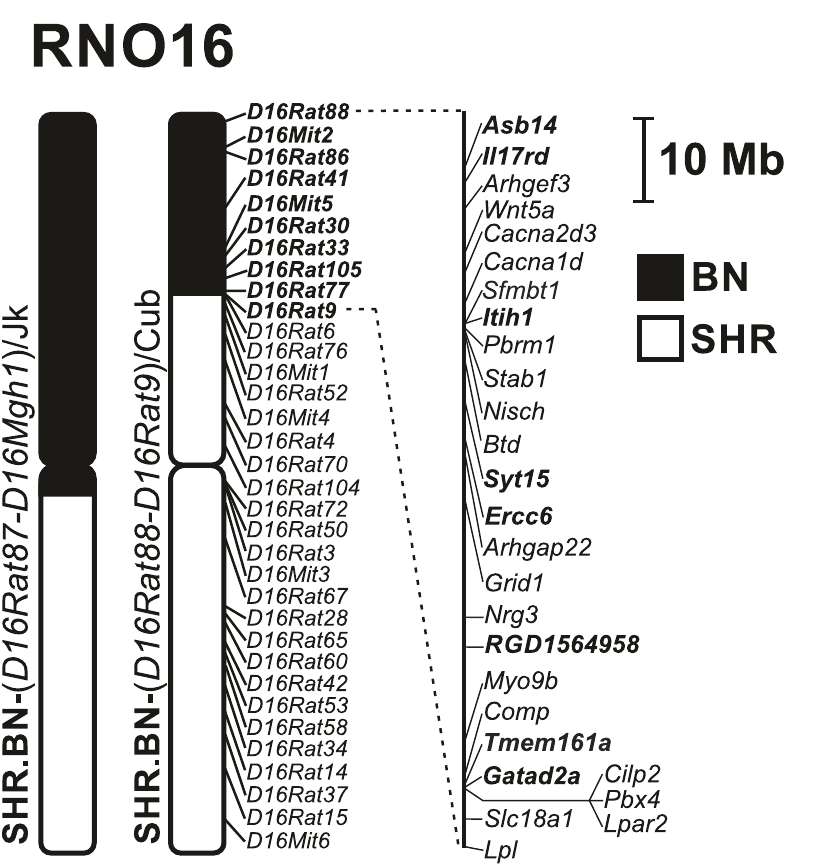
Fig 1. The rat chromosome 16 (RNO16) differential segment in the SHR.BN-( D16Rat88-D16Rat9 )/Cub strain. The RNO16 differential segment in the SHR.BN-( D16Rat88-D16Rat9 )/Cub strain compared with a previously published congenic strain carrying Brown-Norway-origin RNO16 (SHR.BN-( D16Rat87-D16Mgh1 )/ Jk) [13]. The RNO16 markers genotyped in this study to determine the differential segment in the SHR.BN- ( D16Rat88-D16Rat9 )/Cub strain are shown to the right of the chromosome. Chromosomal regions of SHR origin are depicted by open bars; the BN-derived segment is shown as a solid bar. Genes with “ probably damaging ” nonsynonymous mutations distinguishing SHR from BN- Lx are shown in bold . Genes that are associated with features of metabolic syndrome in human genome-wide association studies and that show variance between SHR and BN- Lx ( in silico comparison) are shown in italics. Asb14 — ankyrin repeat and SOCS box-containing 14, Il17rd — interleukin 17 receptor D, Arhgef3 — Rho guanine nucleotide